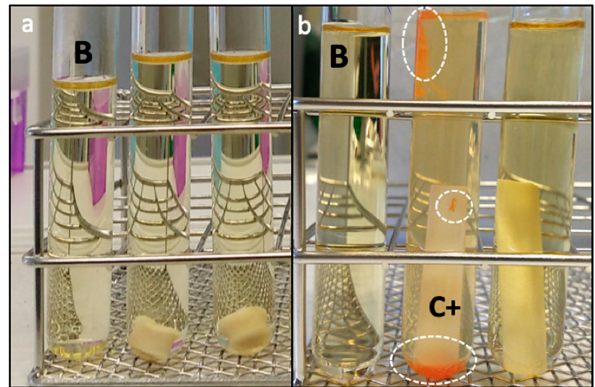
Figure 5. Evaluation of sterilization efficacy of a scCO 2 treatment on starch aerogels: ( a ) Example of lack of turbidity on TSB tubes containing the aerogel [Z1] after a 7-day incubation period, compared to the blank (B); and ( b ) visual differences between untreated (C+,middle) and scCO 2 treated B. atrophaeus strips (right), compared to the blank (B, left). White circles highlight bacterial growth. The characteristic orange-red color due to the growth of these spores was absent in the scCO 2 treated strips and in the